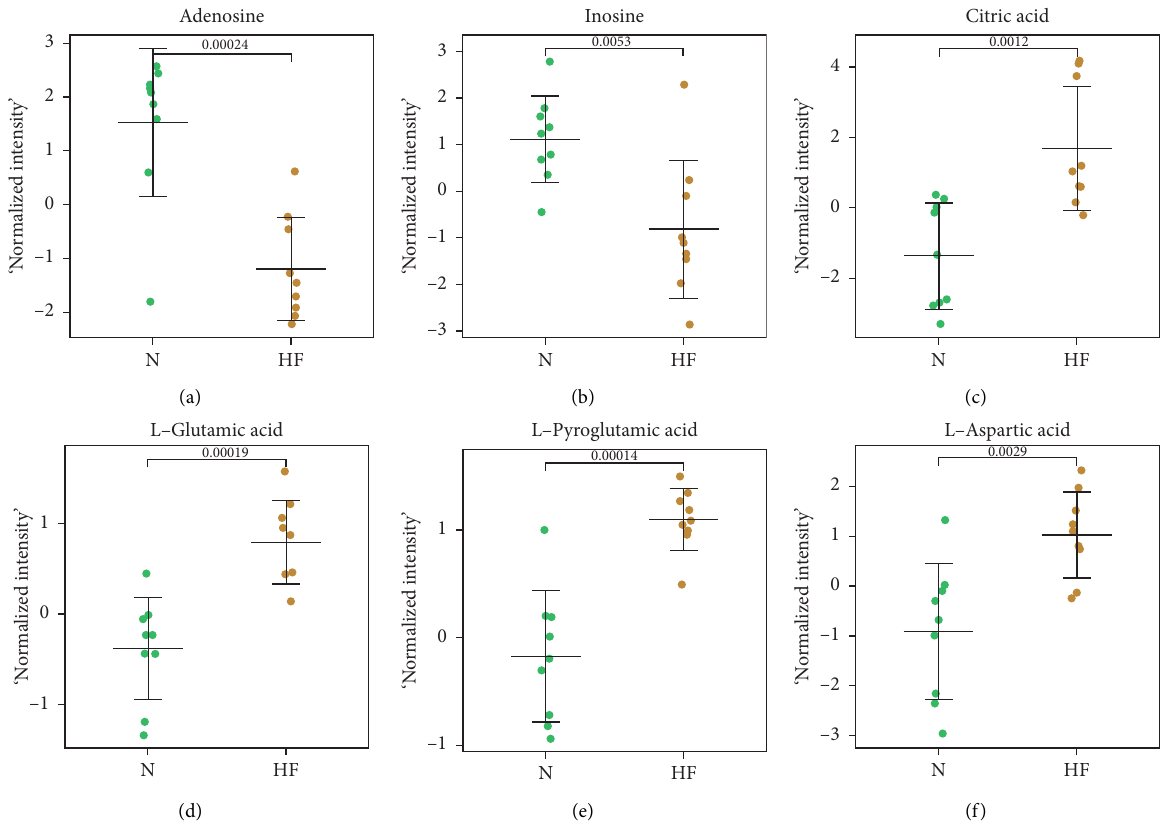
Figure 5: Scatter dot plots of potential biomarkers in the polar phase. All biomarkers shown here fulfilled the criteria of MV. MV criteria were a VIP value > 1. Error bars indicate median and interquartile ranges. MV: Multivariate; VIP: Variable importance for